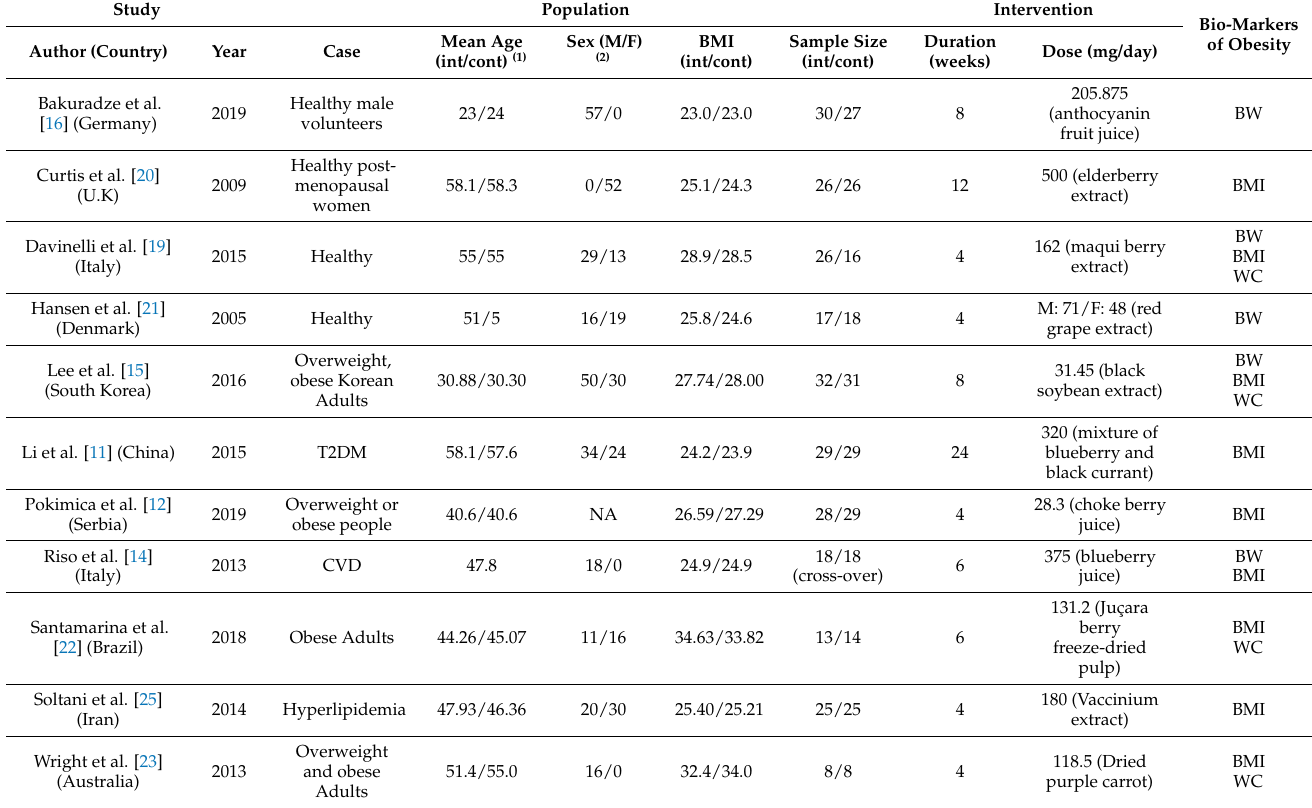
Table 1. Characteristics of included studies.